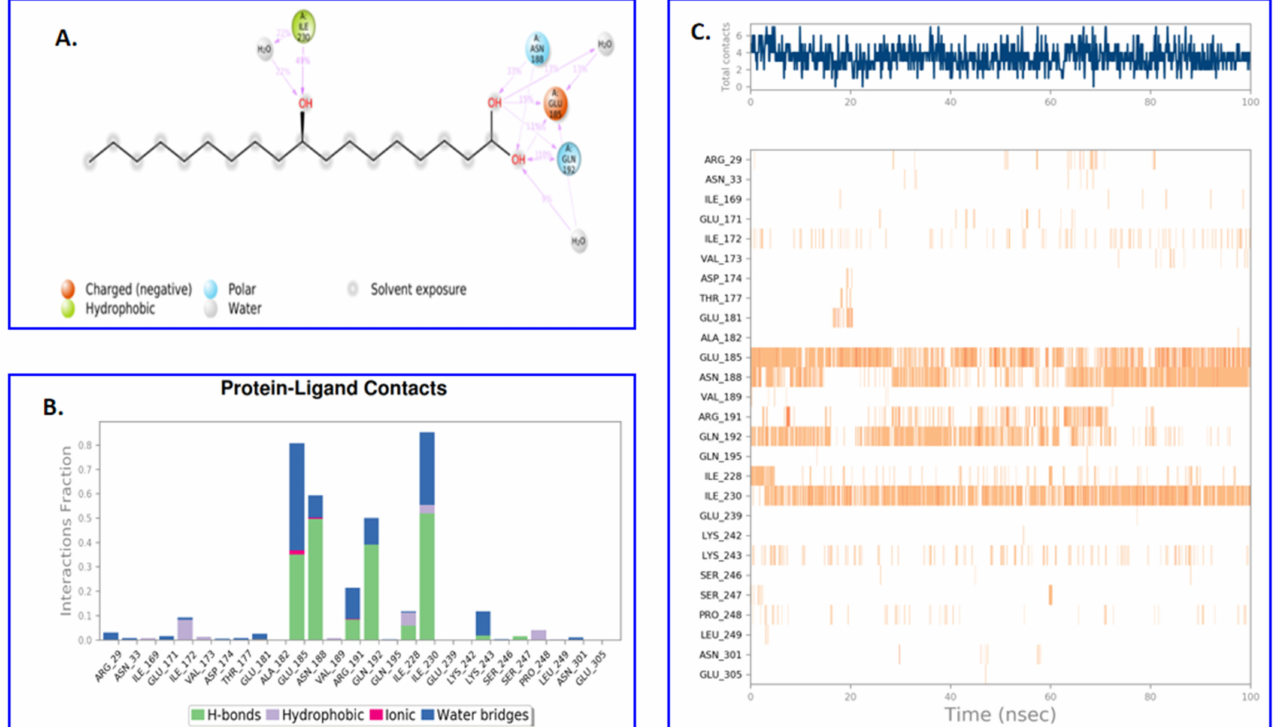
Figure 8. ( A ) Two-dimensional diagram of contacts made more than 9% of simulation time between ADMA (ligand) and Fts-Z (PDB ID-2VXY) (receptor) in 100-ns molecular dynamics. Gln 192 showed a contact time of 110% because it had multiple interactions of a single type with ADMA atoms. ( B ) The plot represents the interaction of the ADMA with 2VXY residues in simulation. ( C ) A timeline representation of residues interacting with the ligand along with density in each trajectory